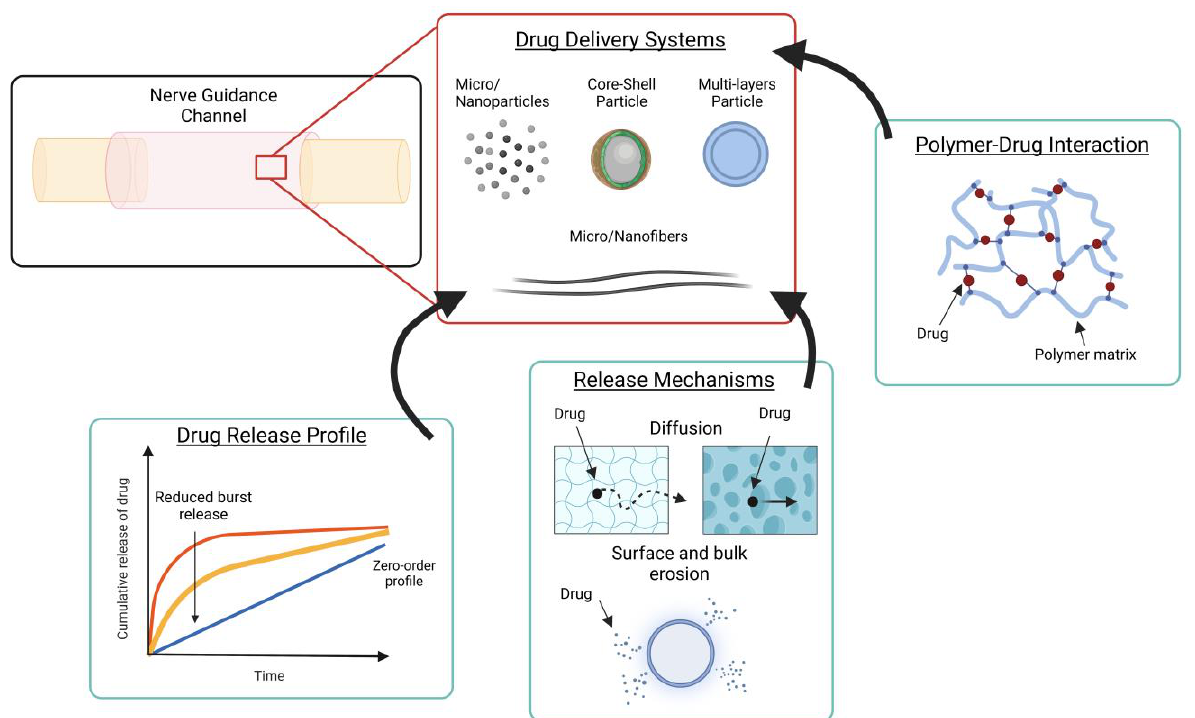
Figure 3. Schematic illustration showing factors that accelerate and promote nerve regeneration by DDS employment. DDS can be incorporated into the NGC to release drugs (i.e., neurotrophic factors, anti-inflammatory drugs, or immunosuppressant drugs). To control drug releases from DDS incorporated within NGC structure, three factors have to be considered (enclosed in green boxes and linked with solid arrows to DDS box in red): drug release profile, release mechanism, and polymer-drug interaction. Created with BioRender.com (3 January 2023).